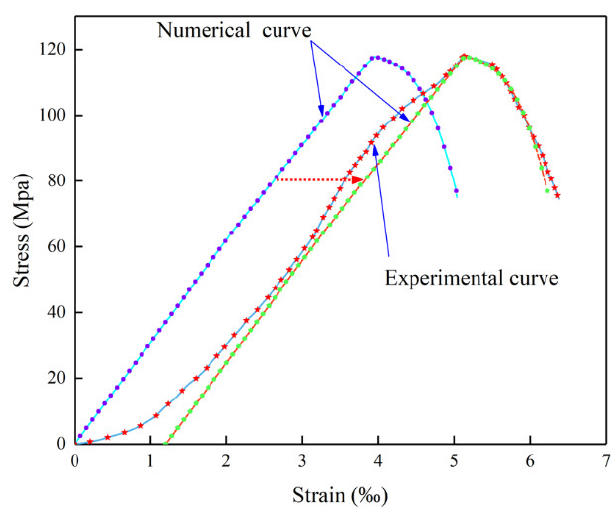
Figure 4. Validation of numerical results.